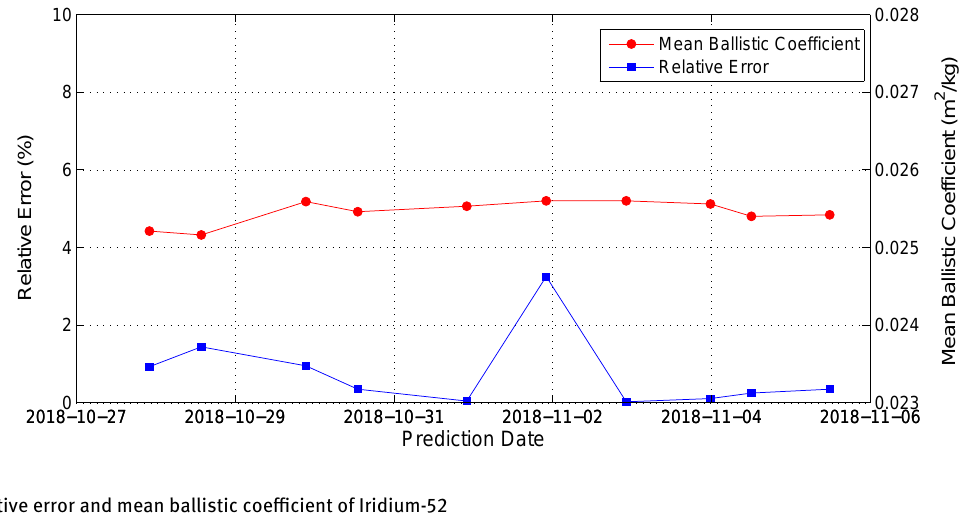
Figure 2. Relative error and mean ballistic coeflcient of Iridium-52 Table 2. Observations information used in re-entry prediction on 2018-10-30